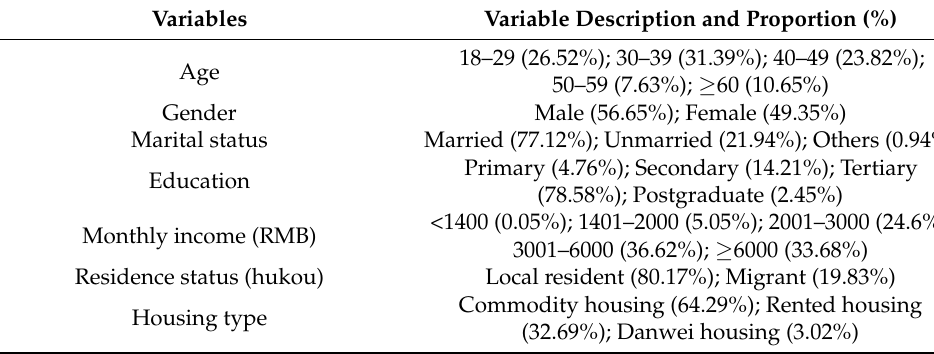
Figure 1. The location of Zhengzhou City. Table 1. The statistics of key sociodemographic